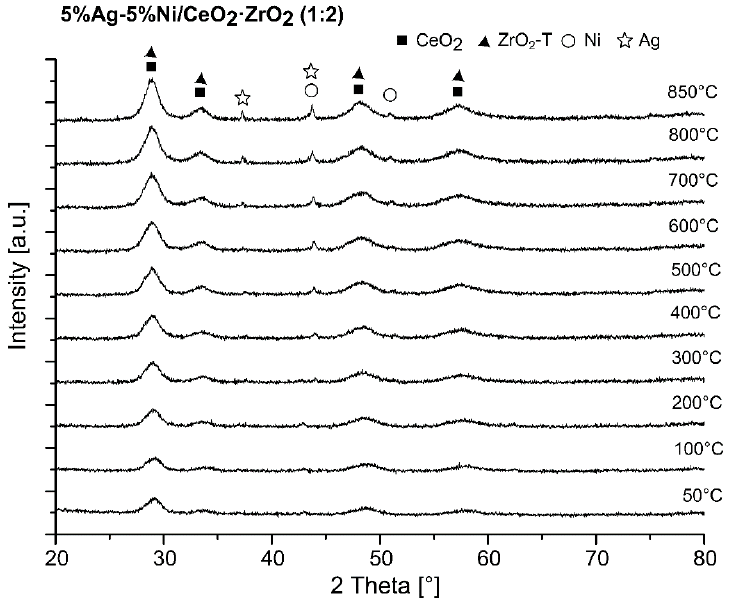
Figure 3. The X ‐ ray diffraction measurements recorded for 5%Ag ‐ 5%Ni/CeO 2 ∙ ZrO 2 (1:2) catalyst performed the in ‐ situ reduction process. performed the in-situ reduction